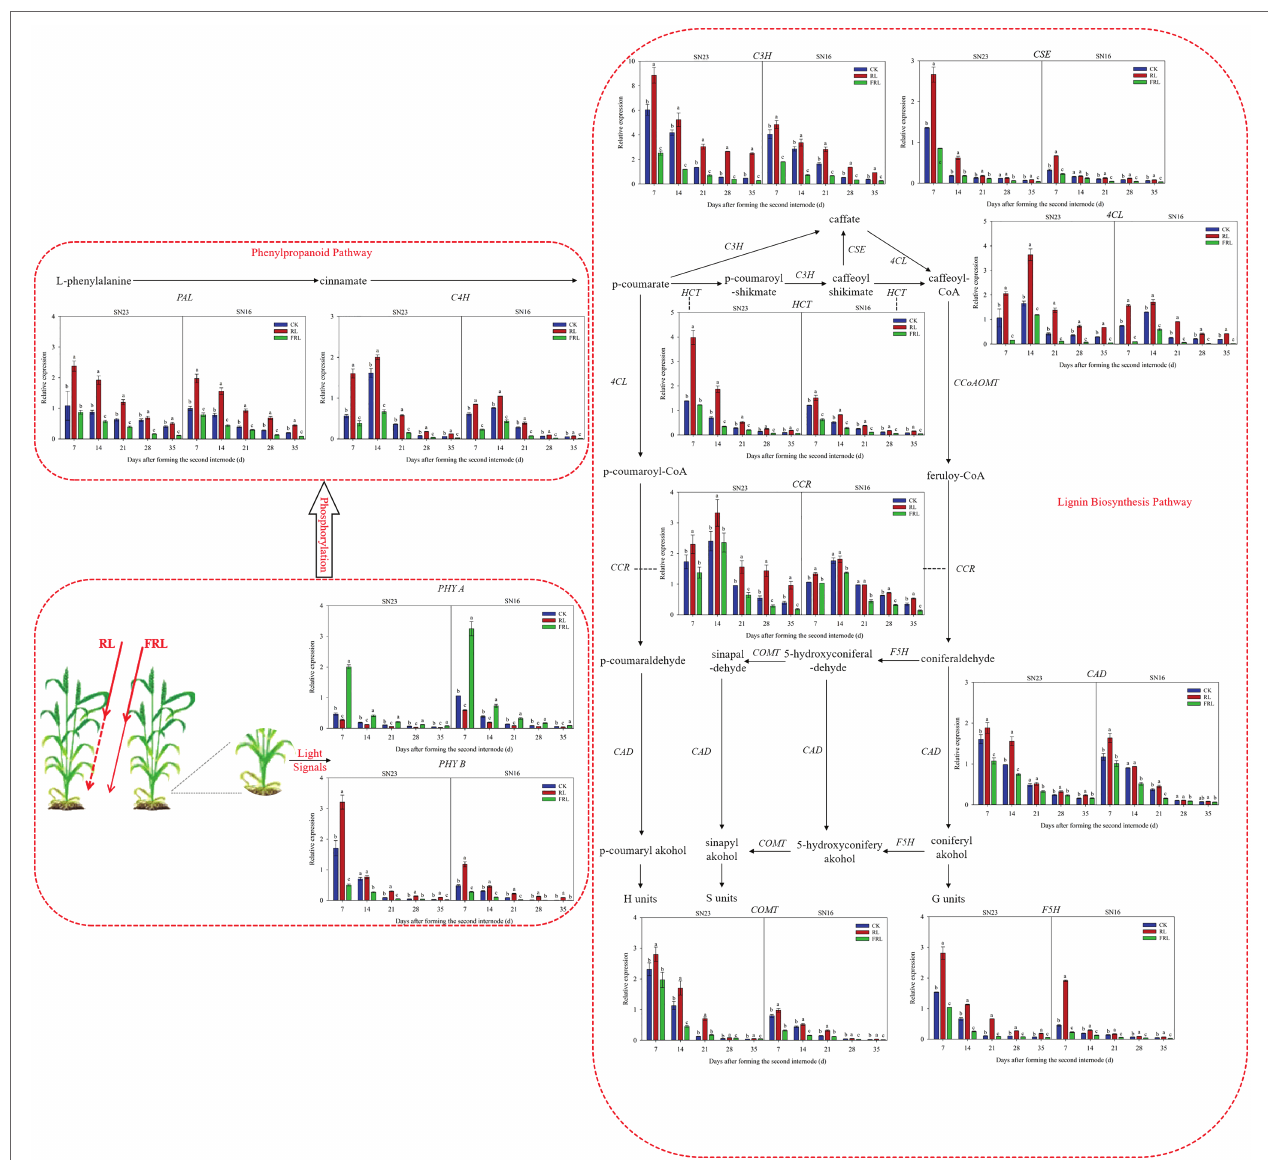
FIGURE 7 | Effects of light quality on real-time quantitative PCR (RT-qPCR) of key genes for phytochrome and lignin synthesis in wheat in 2018–2019 growing seasons. SN16 and SN23 represent the lodging-sensitive cultivar Shangnong16 and the lodging-resistant cultivar Shangnong23. CK represents the normal light, RL represenst the red light, and FRL represents far-red light. Vertical bars above mean values indicate SDs ( n = 3). Means show significant differences between treatments according to the LSD ( p <